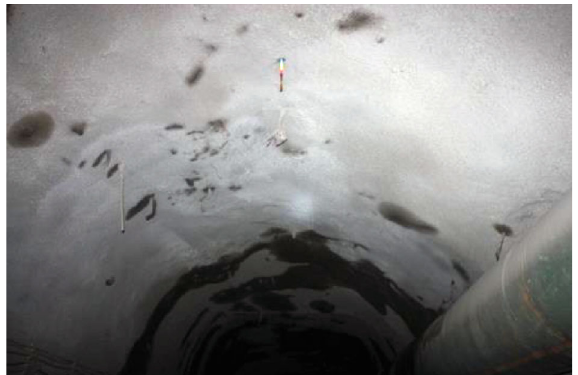
Figure 2: Roadway appearance (without anchor